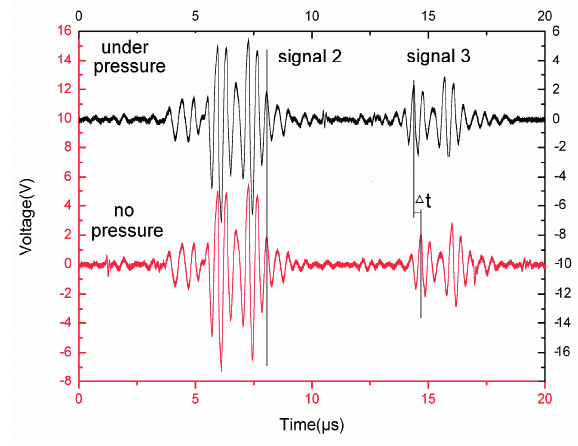
Figure 8. The comparison of ultrasonic echoes with or without